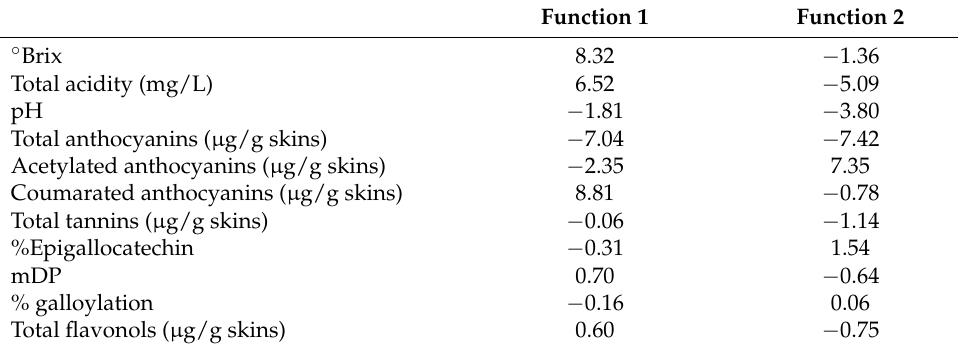
Table 1. Standardised coefficients of the discriminant functions.